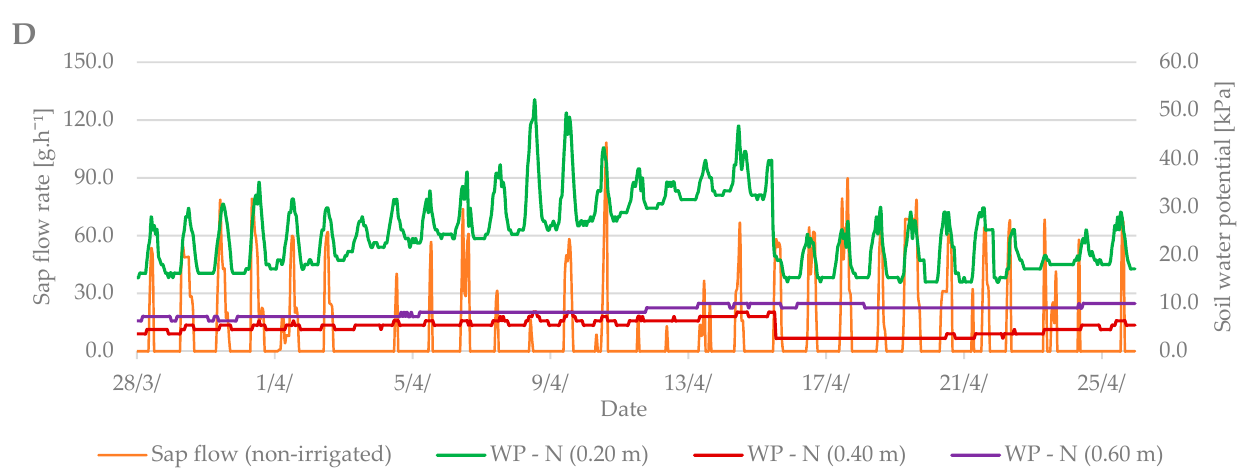
Figure 4. Diurnal course of sap flow rate during the budbreak period in 2019 in the irrigated and non-irrigated treatment depending on ( A ) air temperature; ( B ) amount of natural precipitation; ( C ) soil water potential values in the irrigated variant (WP − I) measured in the depth of 0.20, 0.40, and 0.60 m; and ( D ) soil water potential values in the non-irrigated variant (WP − N) measured in the depth of 0.20, 0.40, and 0.60 m.